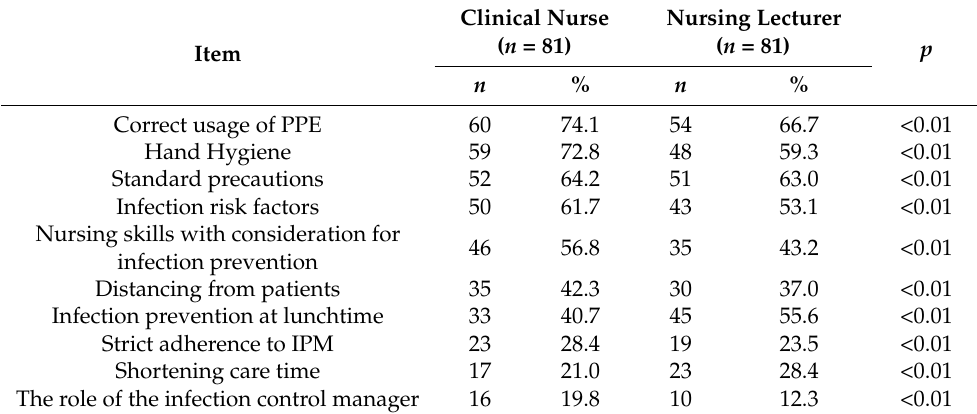
Table 5. A comparison of infection control measures learned by students from a clinical nurse and a nursing lecturer.